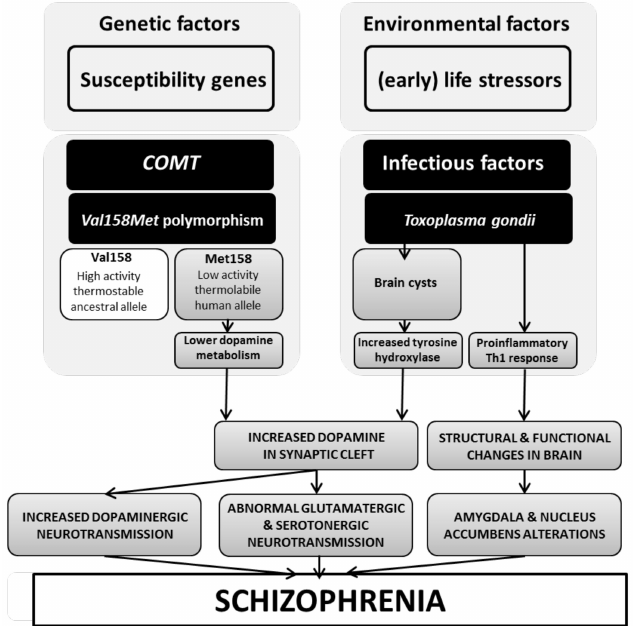
Figure 2. Plausible interaction cascade between COMT and T. gondii infection in